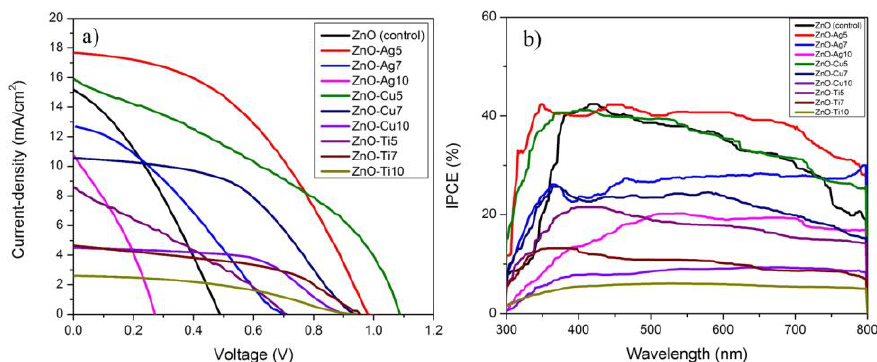
Figure 7. ( a ) J – V curves of pristine ZnO NFs and ZnO (Ag, Cu, and Ti) and ( b ) IPCE curves of pristine ZnO NFs and ZnO (Ag, Cu, and Ti) PSCs. Table 1. PSC parameters consisting of current density ( J SC ), open voltage ( V OC ), fill factor (FF), and power conversion efficiency (PCE).